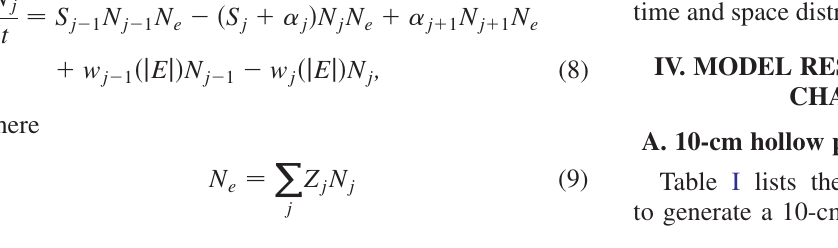
TABLE I. Key parameter values for modeling creation of 10-cm long hollow plasma